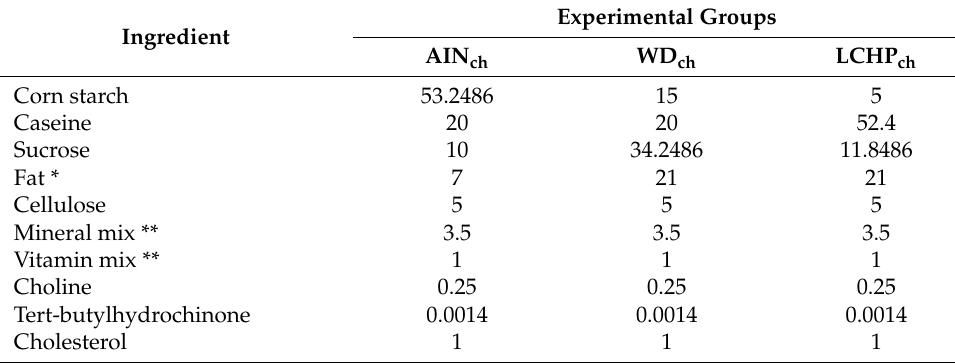
Experimental Groups AIN ch WD ch